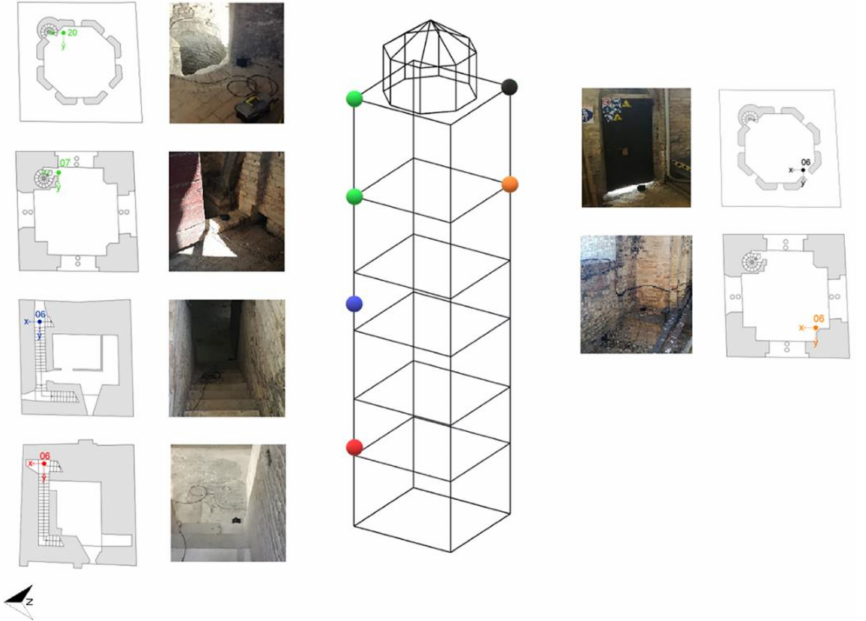
Figure 3. Sensor